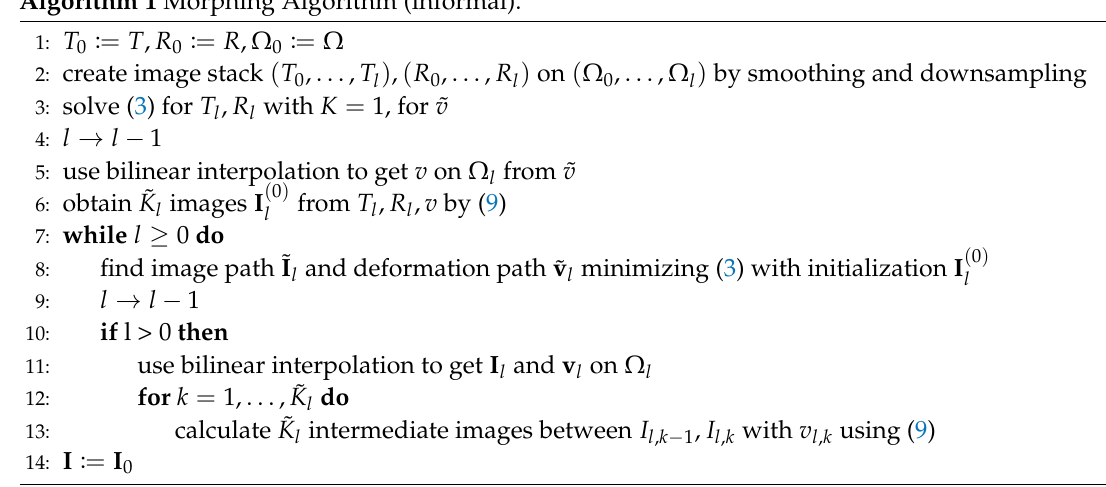
Algorithm 1 Morphing Algorithm